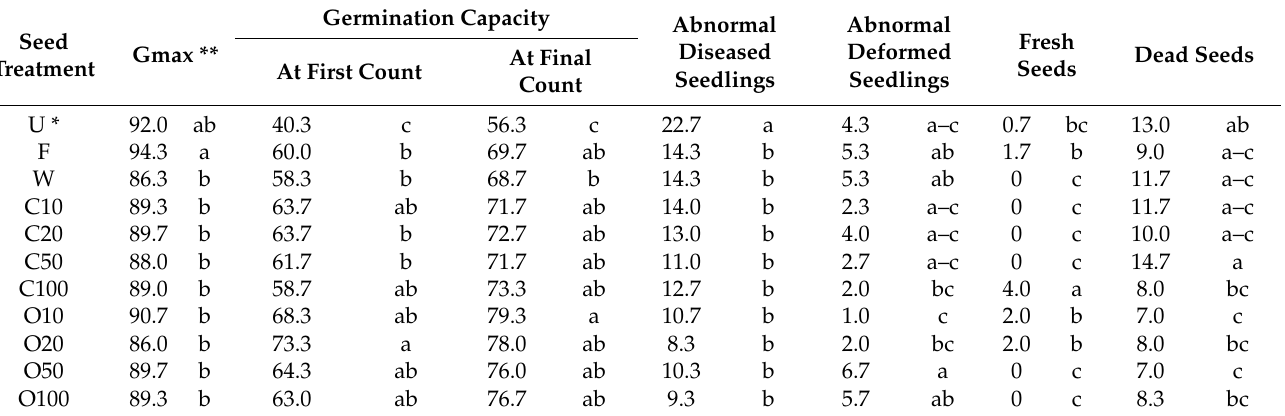
Table 2. Effects of coconut and oregano hydrolates treatment on the seed germination of onion seeds of sample II